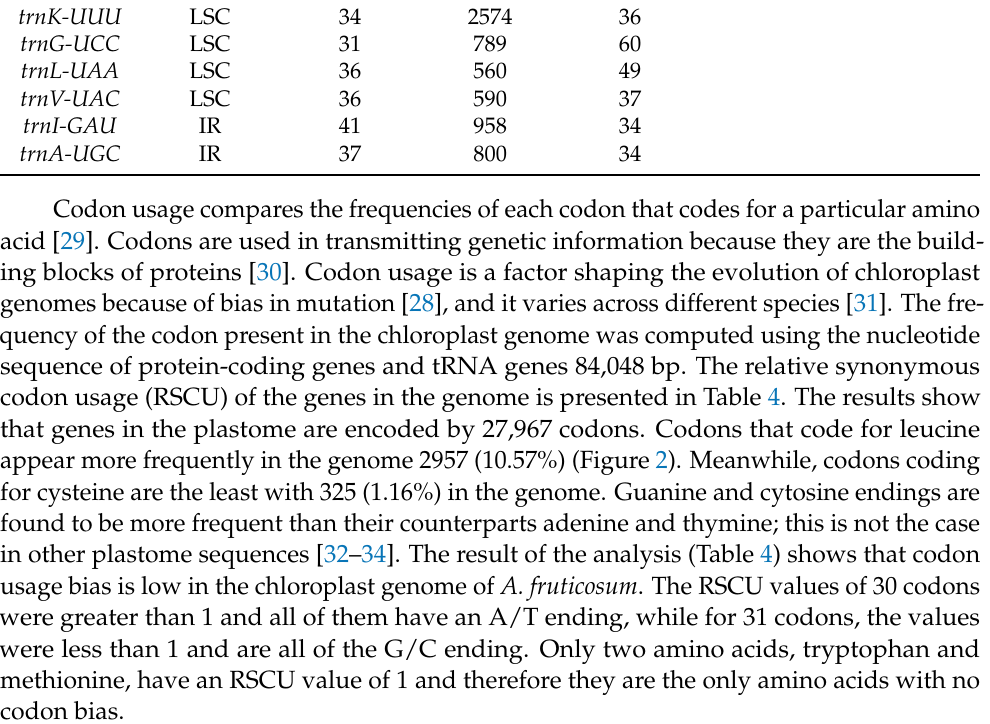
Exon I Intron I (bp)